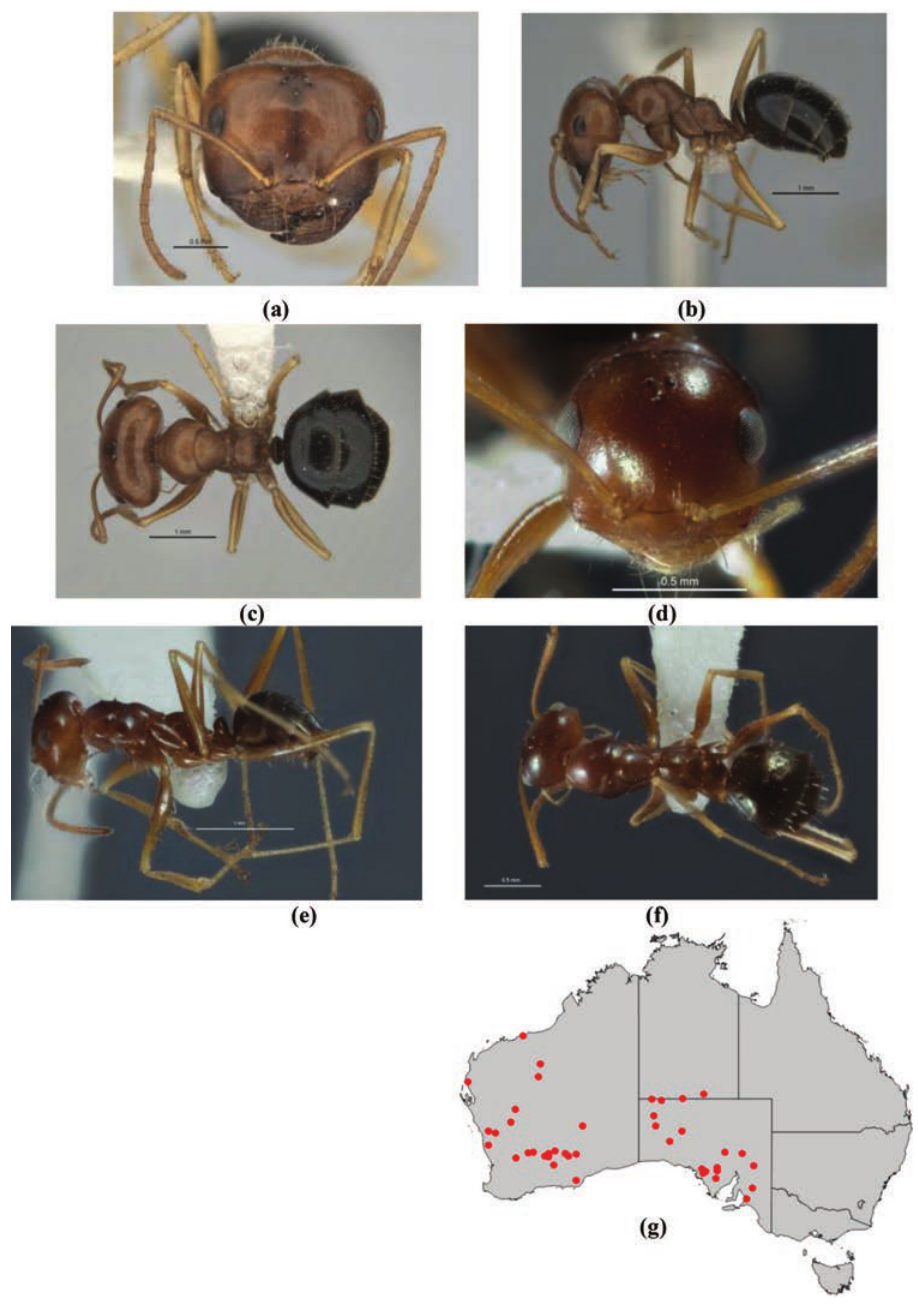
Figure 63. Melophorus longipes sp. n.: major worker paratype (ANIC32-900193–top ant) frons ( a ), pro- file ( b ) and dorsum ( c ); minor worker holotype ([ANIC] Mt Ive. Homestead, SA, 22 Oct. 1880, P.J.M. Greenslad e–b ottom ant) frons ( d ), profile ( e ) and dorsum ( f ); distribution map for the species ( g ). Low resolution scale bars: 1 mm ( b, c, e ); 0.5 mm ( a, d, f